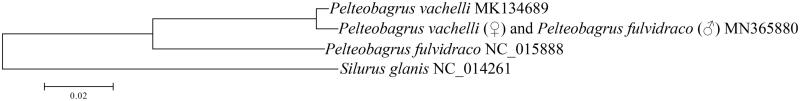
Neighbor-joining phylogenetic tree inferred from amino acid sequence dataset of 13 protein-coding genes. The tree shows the topology based on concatenated data of 13 mitochondrial encoded protein sequences. Reconstruction was performed by MEGA X (64-bit).